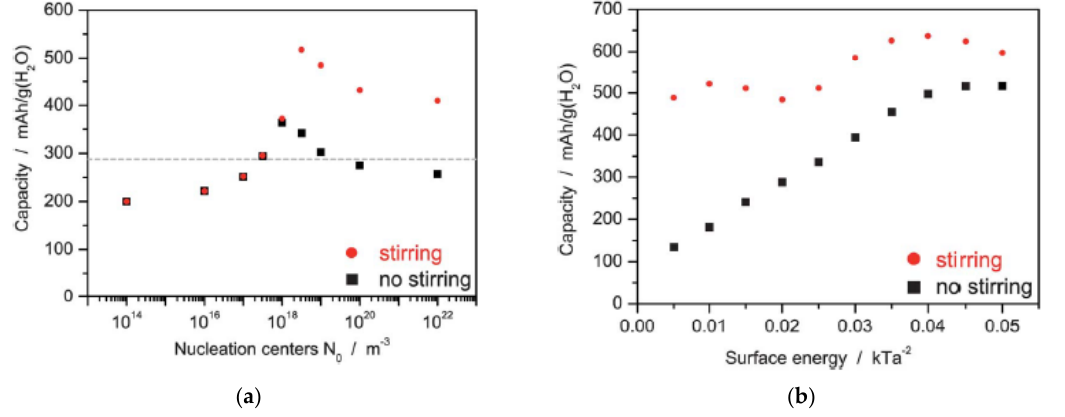
Figure 23. Discharge capacity of a Li-air battery after galvanostatic discharge at i = 10 A/m 2 with nucleation on dust particles as a function of density of ( a ) nucleation centers in the separator and ( b ) surface energy. Reprinted from Horstmann et al. [29], with permission from The Royal Society of Chemistry.